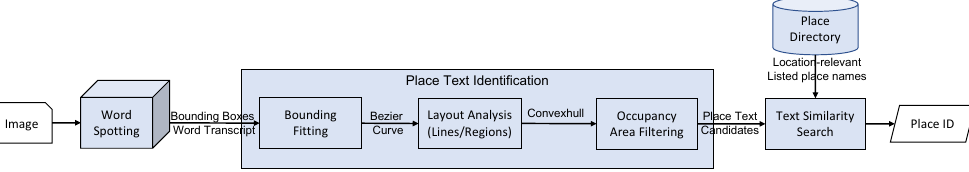
Figure 5. The proposed VPR through text reading pipeline (VPRText). Given a query image, the pipeline goes through 3 main stages to output the place identifier. (1) Word spotting—detection and recognition of all word instances; (2) Place text identification—(i) transform bounding shapes into bezier curve fitting, (ii) performs layout analysis (i.e., words into lines/regions appropriately), and (iii) removal of irrelevant words by occupancy area (e.g., product boards, banners, etc.) to obtain display place texts candidates; (3) Text similarity search—performs iterative similarity scoring between place text candidates and listed place names to obtain the top matching place